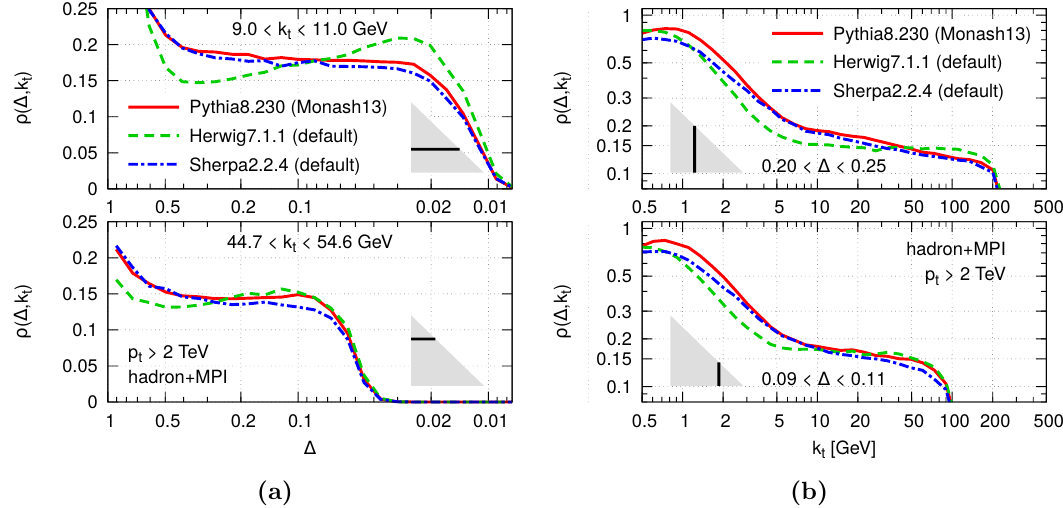
Figure 3. Emission density along slices of the Lund plane, at (cid:12)xed k t (top) and (cid:1) (bottom), comparing three event